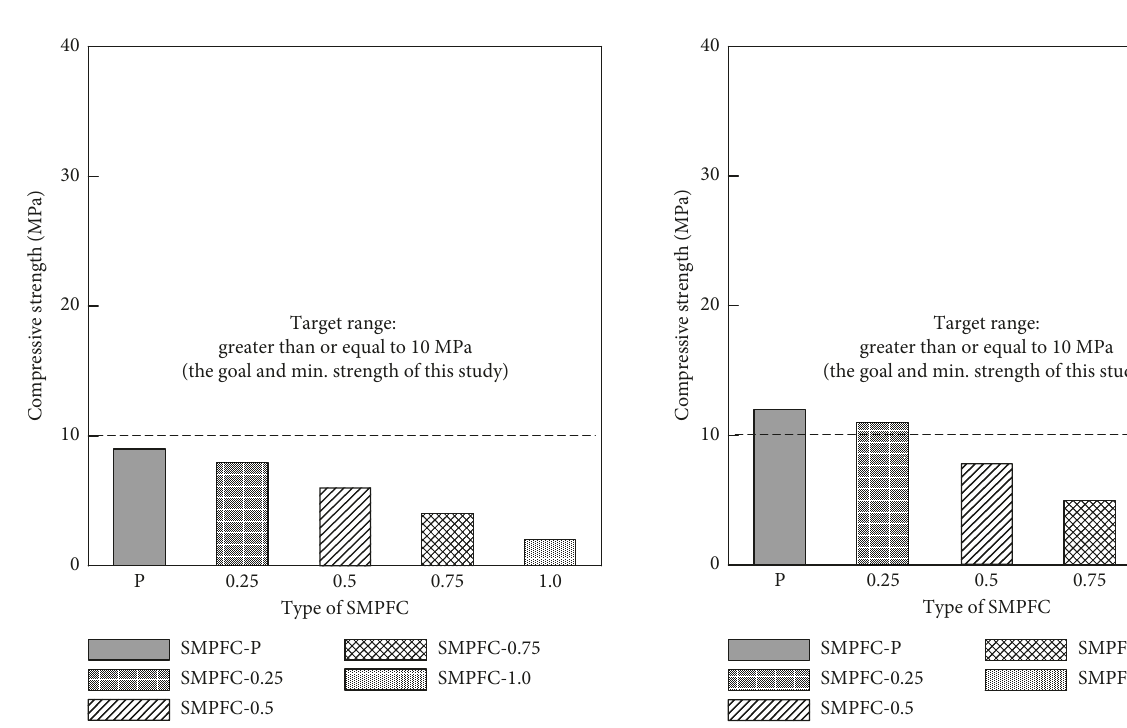
Figure 3: Test results of compressive strength (6H).